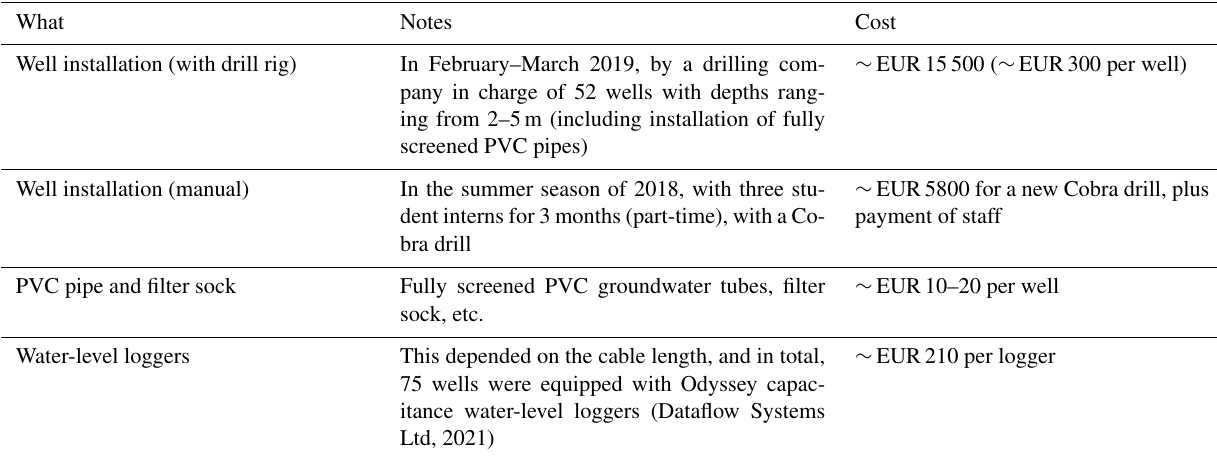
Figure 2. Maps of the two study areas, with area A in panel (a) and area B in panel (b) . The locations of the 75 wells (triangles) that were either augured by hand (manual; in light gray) or installed by the drill rig (dark gray) are also shown. The letters next to each triangle indicate the name of the well. See Fig. 1 for the location of the two study areas within the Krycklan catchment. Table 1. Estimated costs for installing the well